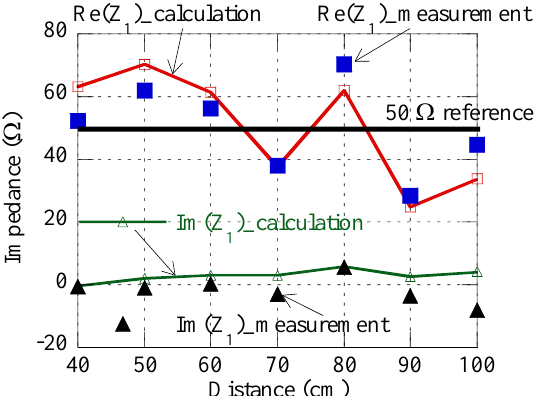
Figure 8. Comparison between calculated and measured input impedance (Z 1 ) of the fabricated system.